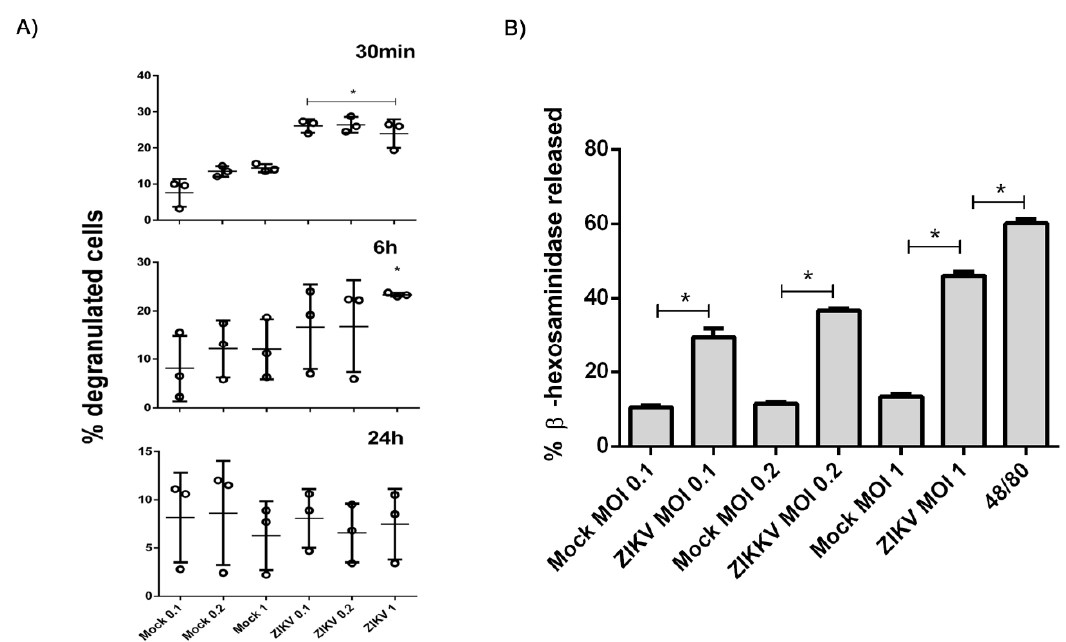
Figure 3. Kinetics of mast cell degranulation after interaction with ZIKV. ( A ) Percentage of degranulated cells after incubation with di ff erent MOIs of ZIKV in 30 min, 6 h and 24 h by flow cytometry. ( B ) Percentage of β -hexosaminidase release with di ff erent MOIs of ZIKV after 30 min. The synthetic compound 48 / 80 was used to elicite mast cell degranulation. * Statistically significant di ff erences between groups (same time of infection) assessed by a Mann–Whitney test ( p < 0.05). Data represent the mean of duplicate values for each sample, in three independent experiments.